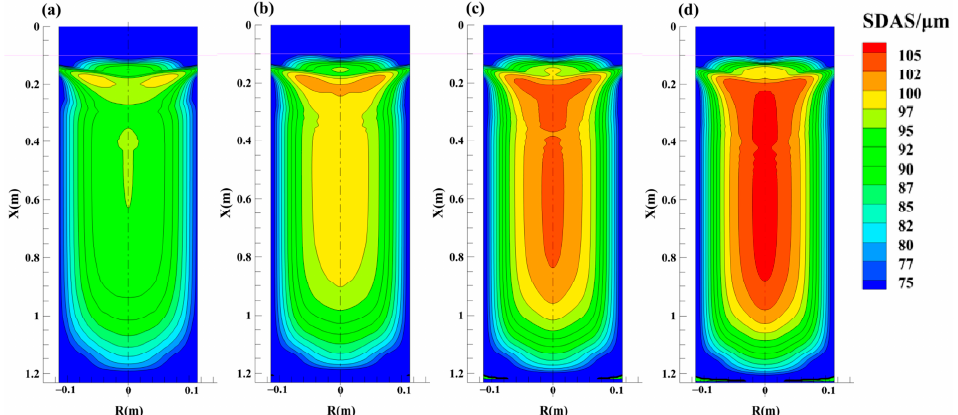
Figure 11. Distribution of SDAS at varying melting rate: ( a ) 90 kg/h, ( b ) 120 kg/h, ( c ) 150 kg/h and ( d ) 180 kg/h.